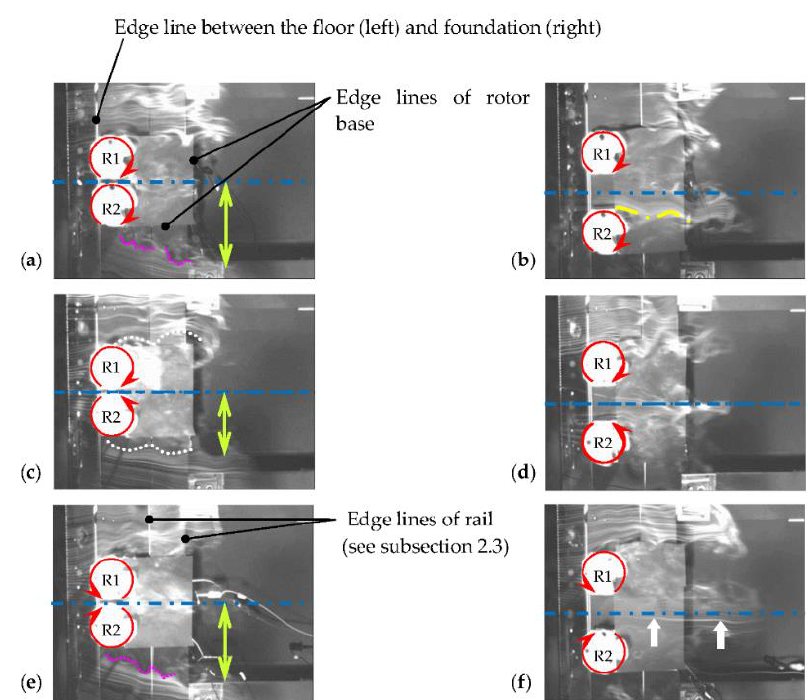
Figure 11. Photographs of smoke flow past two rotating turbines arranged side-by-side at g = 10 and 50 mm at t = 0.25 s under V = 1 m/s: ( a ) CO at g / D = 0.2; ( b ) CO at g / D = 1.0; ( c ) CU at g / D = 0.2; ( d ) CU at g / D = 1.0; ( e ) CD at g / D = 0.2; ( f ) CD at g / D = 1.0.